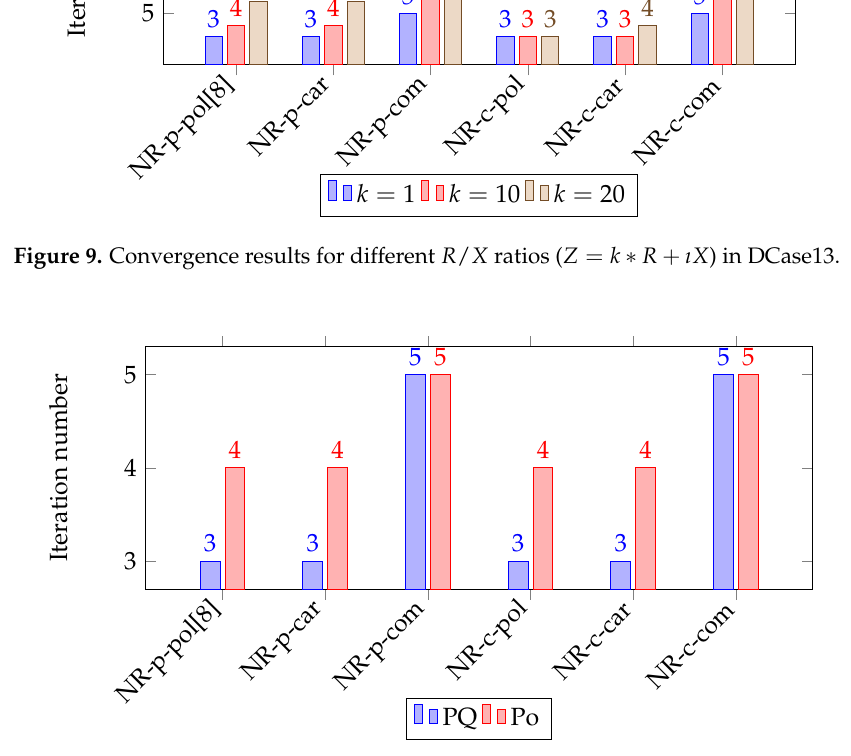
Figure 10. Convergence result for different load models (constant power (PQ) and polynomial (Po)) in